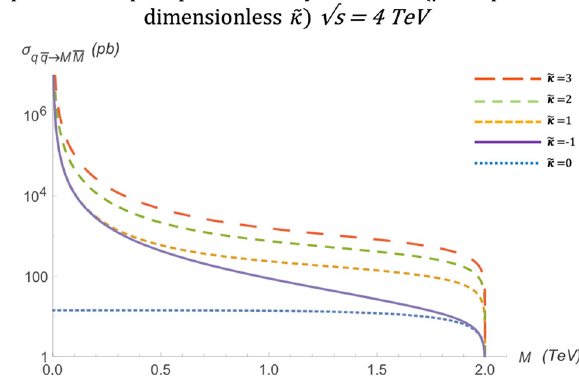
Fig. 13 Total cross section for the pair production of spin- 1 / 2 monopoles via the DY process, as a function of the monopole mass √ M for different values of ˜ κ at s qq = 4